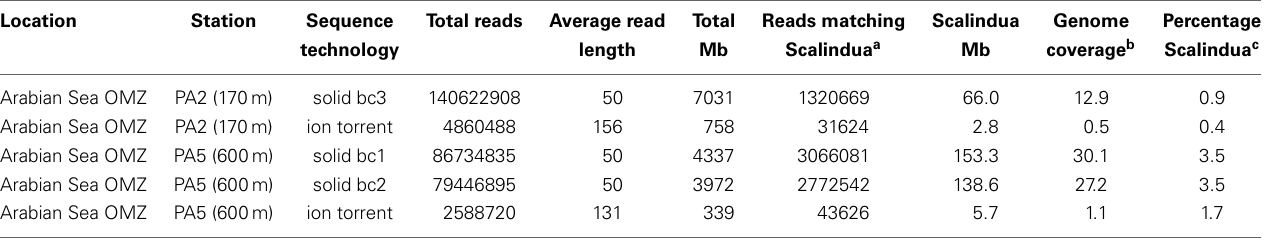
Table 1 | Overview Arabian Sea